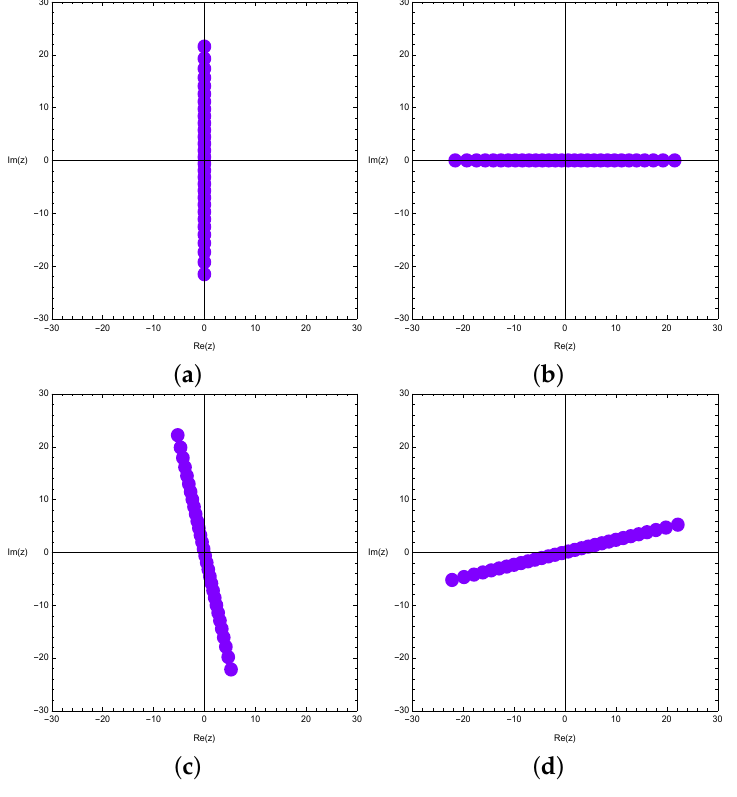
Figure 2. Zeros of H n ( x , y , λ ) = 0. ( a ) n = 30 and y = 2; ( b ) n = 30 and y = − 2 ; ( c ) n = 30 and y = 2 + i ; ( d ) n = 30 and y = − 2 − i